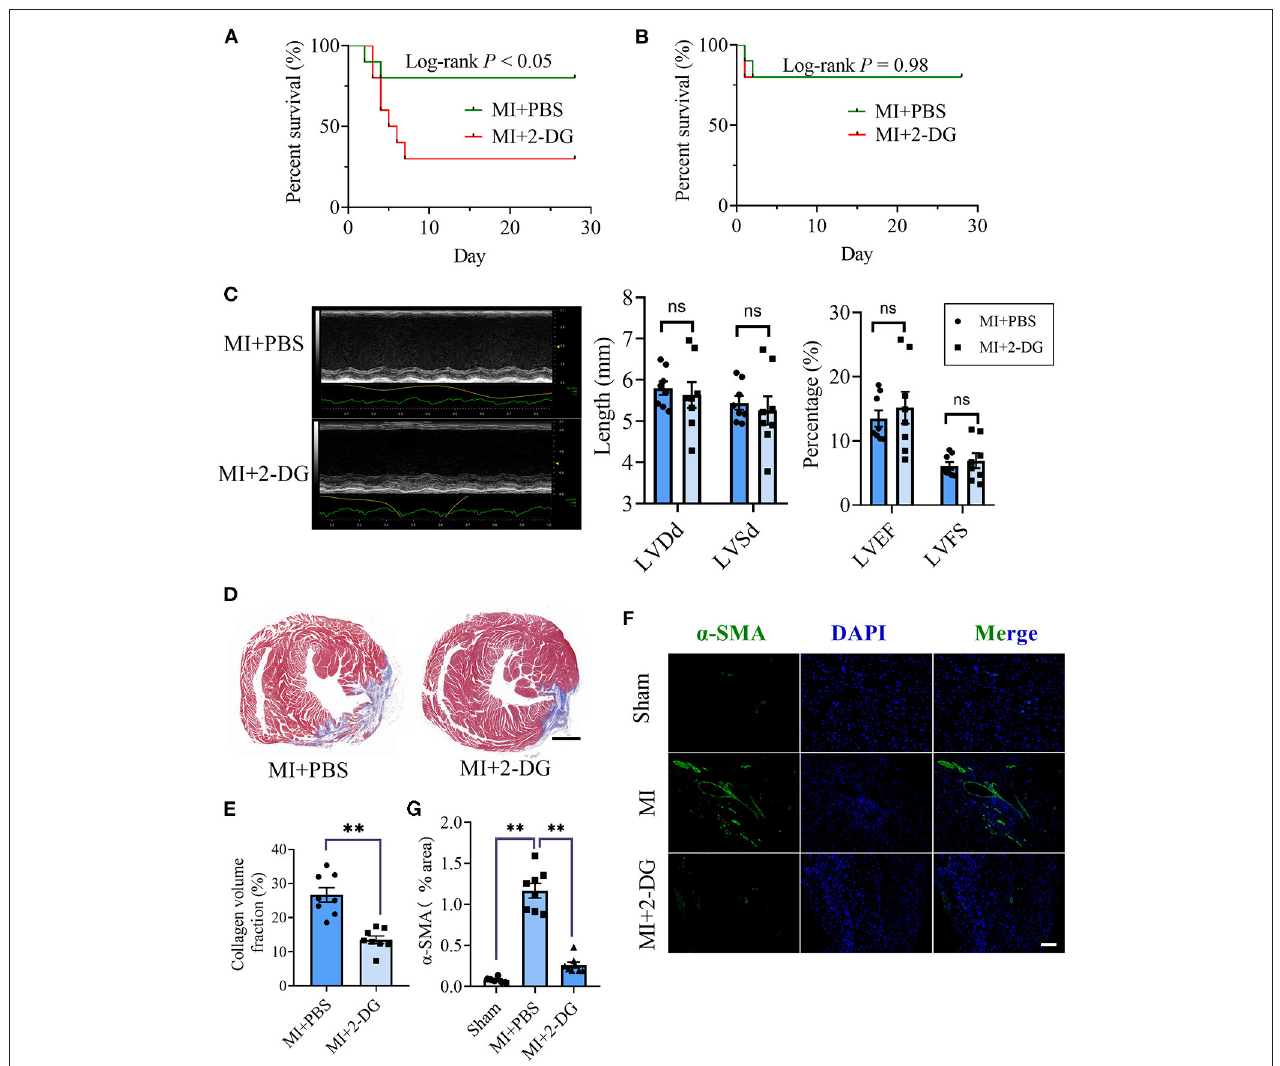
FIGURE 2 | Glycolysis inhibition alleviates cardiac fibrosis after MI. (A) Survival analysis of the mice undergoing MI or sham surgery when 2-DG was delivered immediately after the surgery at a dosage of 100 mg/kg/d. (B) Survival analysis of the mice undergoing MI or sham surgery when 2-DG treatment was started on the 4th day after the surgery at a dosage of 50 mg/kg/d. (C) The cardiac function of the MI mice with or without 2-DG treatment at a dosage of 50 mg/kg/d started on the 4th day after the surgery was measured by echocardiography. Representative images of the M-mode of the echocardiography results (left), and the related parameters (LVEF, LVFS, LVDd, LVSd) measurement (right) were displayed, respectively. (D,E) The hearts of the MI mice with or without 2-DG treatment at a dosage of 50 mg/kg/d started at the 4th day after the surgery were harvested on the 28th day after the surgery. Masson staining was performed. Representative image (D) and the statistical analysis (E) were shown, respectively. (F) Immunofluorescence of the hearts from the MI and sham mice with or without 2-DG treatment. The green fluorescence signal represented α -SMA, and the blue fluorescence signal represented DAPI. (G) Fluorescence signal statistics of the green α -SMA signals. LVEF, left ventricular ejection fraction; LVFS, left ventricular fractional shortening; LVDd, left ventricular end diastolic dimension; LVSd, left ventricular end systolic diameter; MI, myocardial infarction; Sham, sham operation; n = 8; ns, no significance; ** P < 0.01. The scale bar in (D) was 1000 µ m. The scale bar in (F) was 100 µ